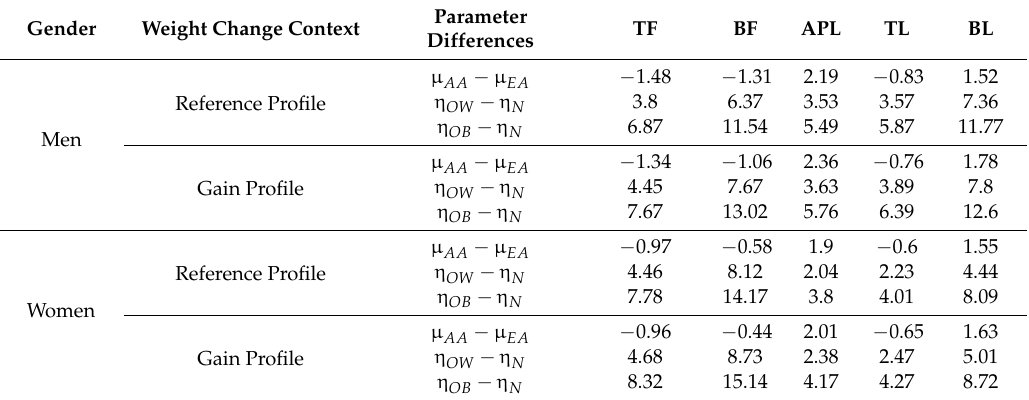
Table 8. Parameter differences of the ethnicity and BMI categories from their baselines, which were “Ethnicity = EA” and “BMI = normal weight”, respectively. Values are given for men and women, according to the retained model M 11 B , E ( A )